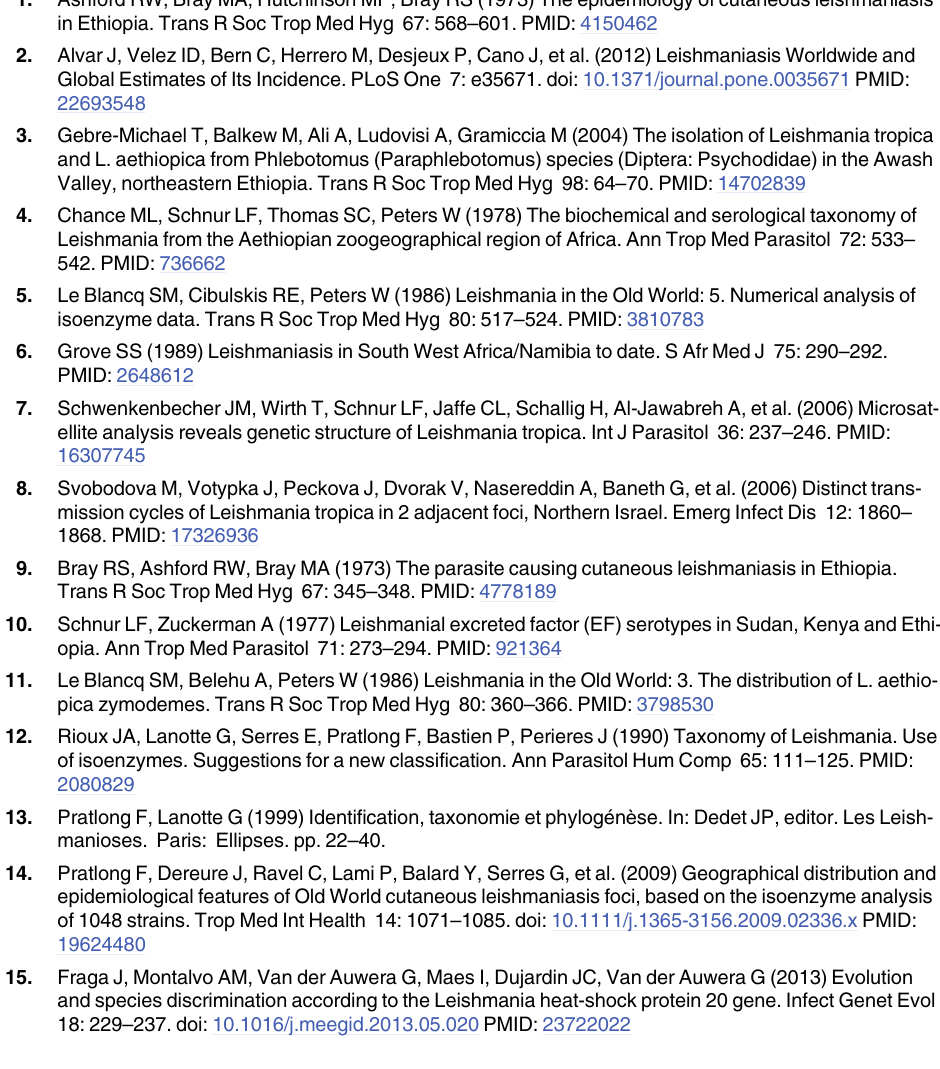
S2 Table. Estimation of the genetic distances between the sub-populations. The mean fixa- tion indices ( F ) result from pairwise comparisons of the distinct sub-populations. Values are ST categorized into little ( < 0.05), moderate (0.05 – 0.15), great (0.15 – 0.25), and very great ( > 0.25) differentiation. Insignificant values are indicated by an asterisk ( (cid:1)